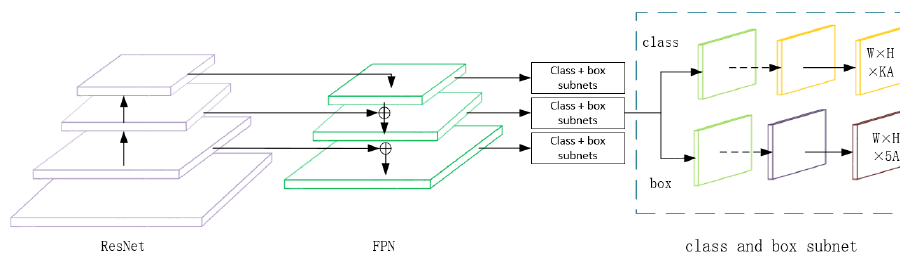
Figure 11. The network architecture of Rotated RetinaNet.